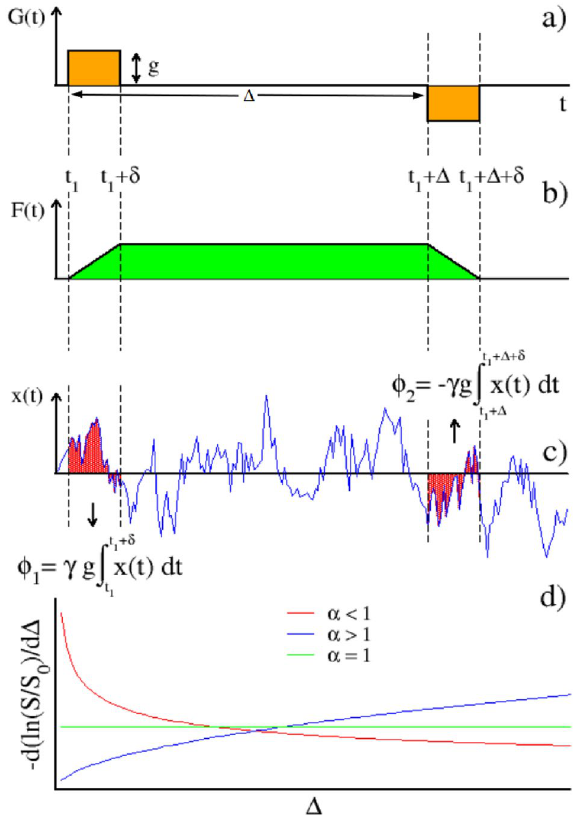
Figure 1. PFG and anomalous diffusion. Panel ( a ) A schematic representation of the couple of magnetic field gradients in PFG-based sequence. Panel ( b ) Integral function F ( t ) of the gradient in panel ( a ). Panel ( c ) phase accumulating during the gradient pulses: the same scheme has been used to obtain the DW-NMR signal from stochastic trajectories (see “Methods” section). Panel ( d ) Expected behavior of the derivative of the logarithm of the normalized echo amplitude for different values of the anomalous diffusion exponent α . For subdiffusive processes the derivative is a decaying function of (cid:31) , for superdiffusive processes it is an increasing function, whilst for normal diffusing systems it is